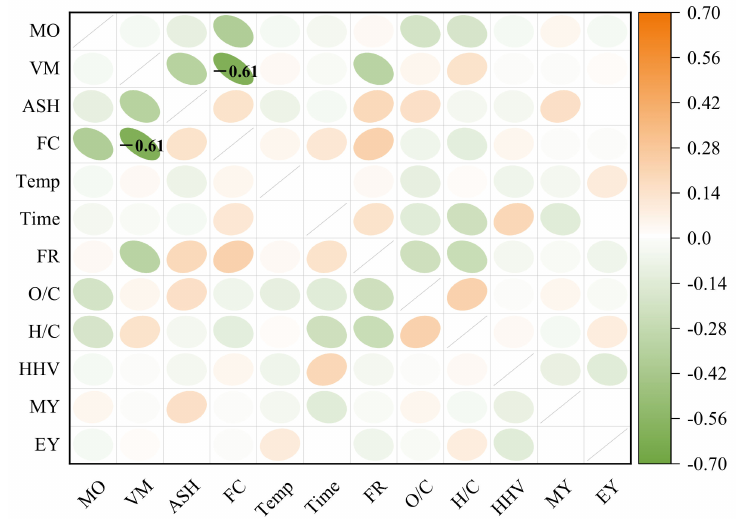
Figure 4. Pearson correlation matrix between any two